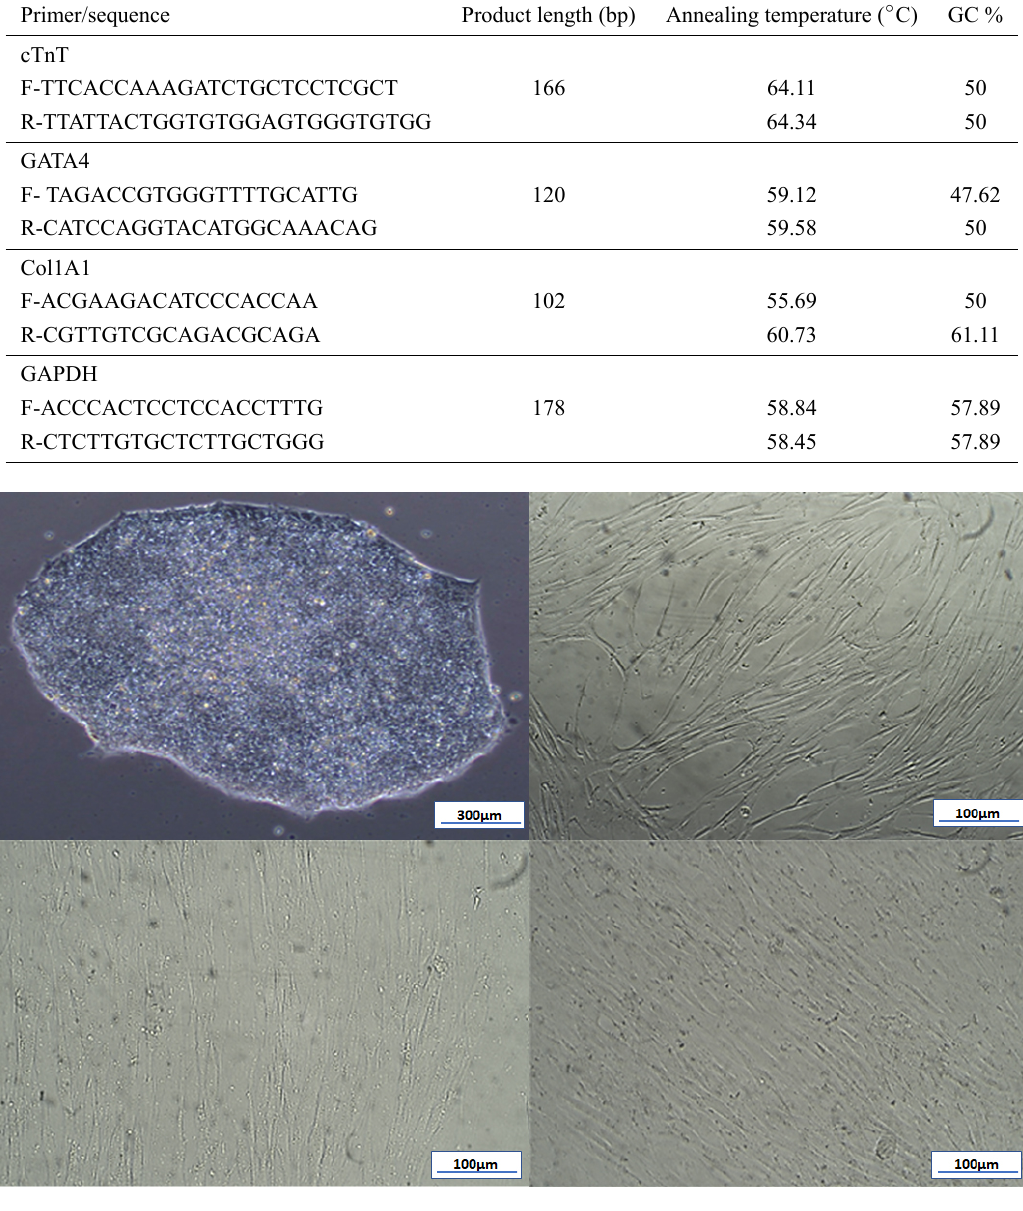
Fig. 2. Slight Changes in cell morphology during differentiation process using three distinct treatments . (A) hiPSCs (100 × ). (B) Differentiated cells using cocktail CHIR99021, bFGF and BMP4 (40 × ). (C) Differentiated cells using XAV939 (40 × ). (D) Differentiated cells using phytoestrogen (40 ×